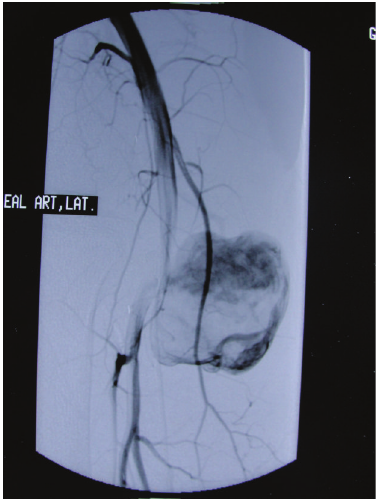
Figure 1: The arteriography of the popliteal artery showed the pseu- doaneurysm.